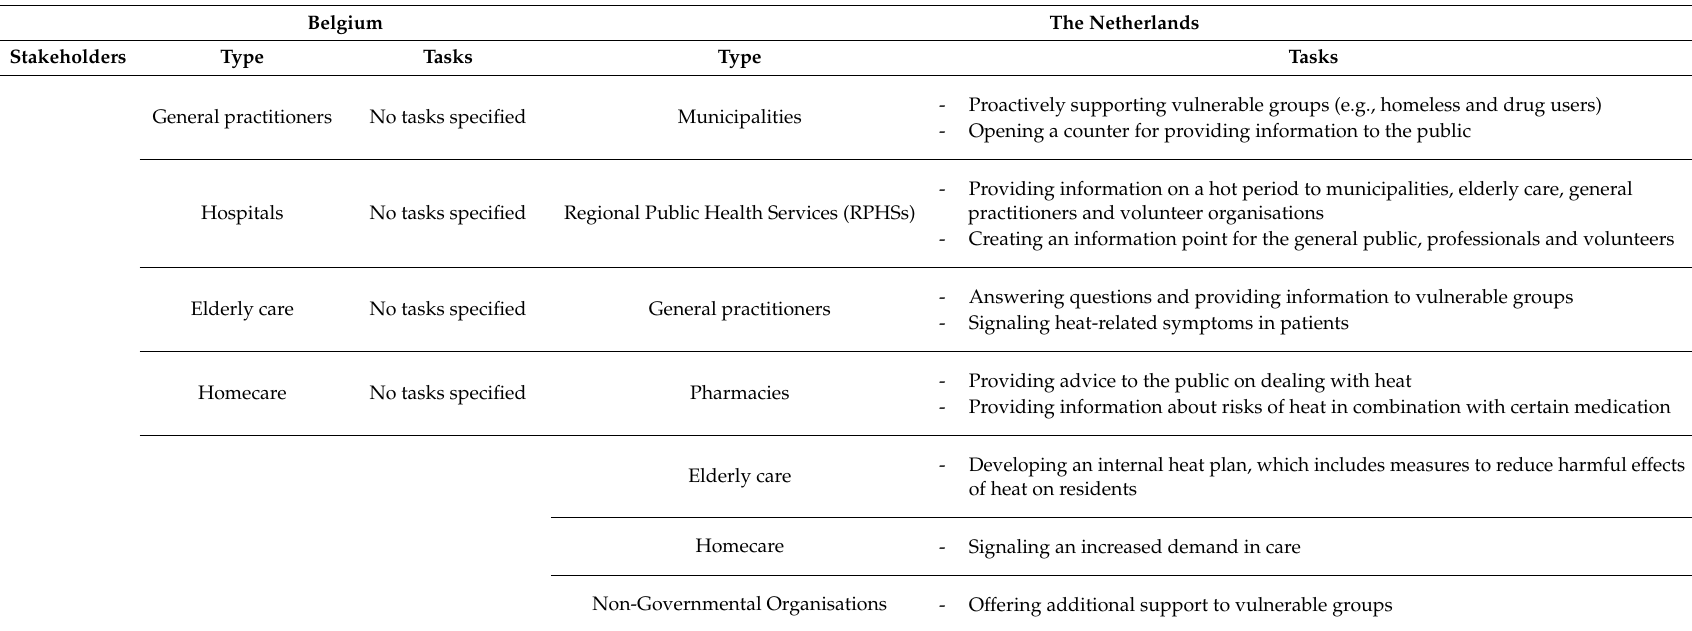
Table 2. Overview of the different stakeholders included in the Belgian and Dutch National Heatwave